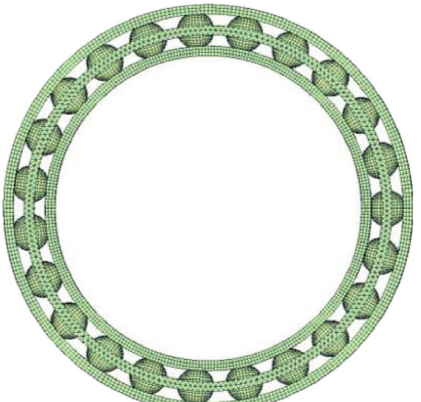
Figure 8: Finite element model of flexible bearing.